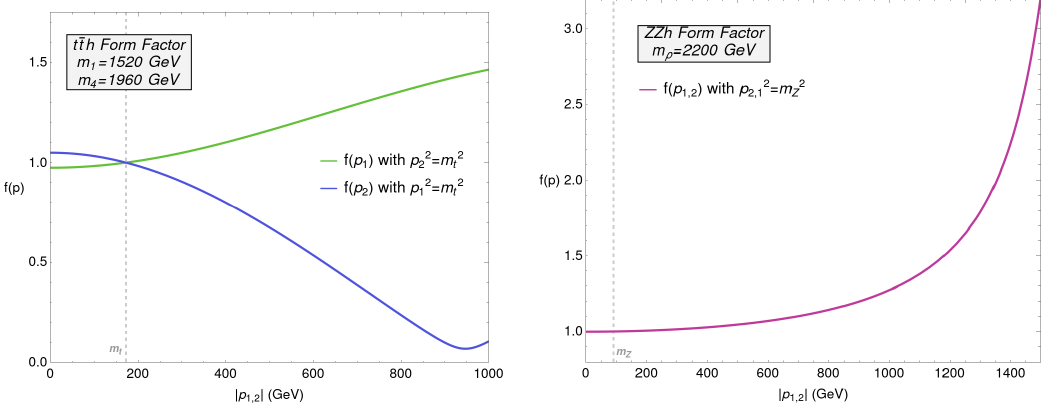
Figure 4 . Left: t ¯ th form factor from (3.29). Right: ZZh form factor from (3.39).